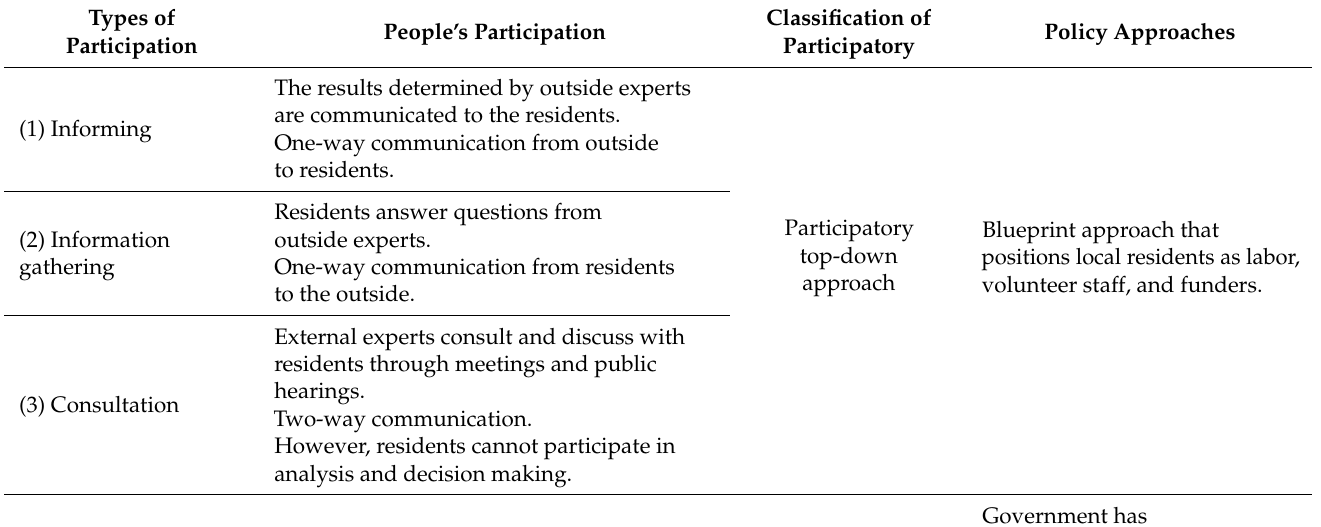
Table 2. Type and classification of participation and policy approach. Source: based on